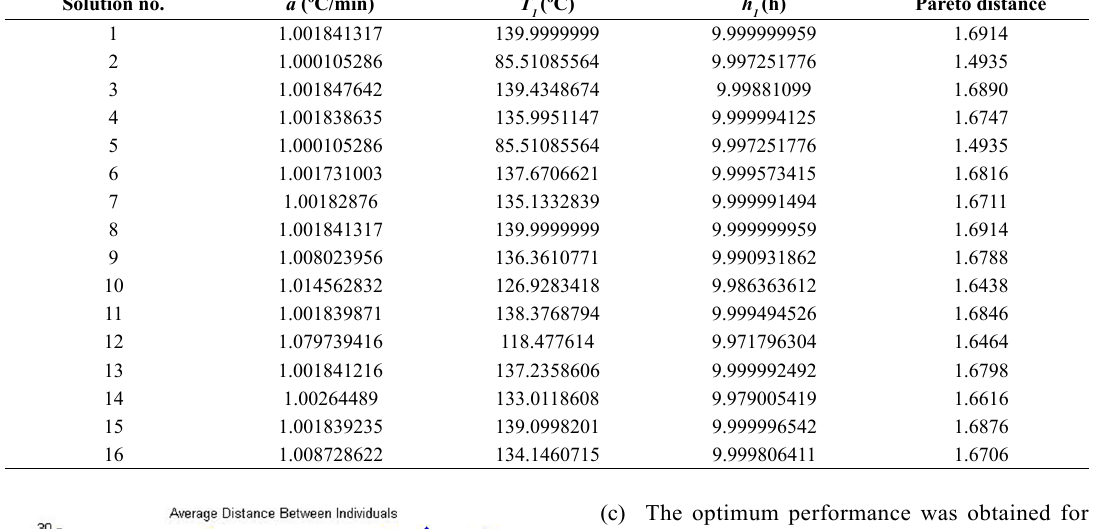
Table 11. Pareto font-function values and optimal curing parameters. Solution no.